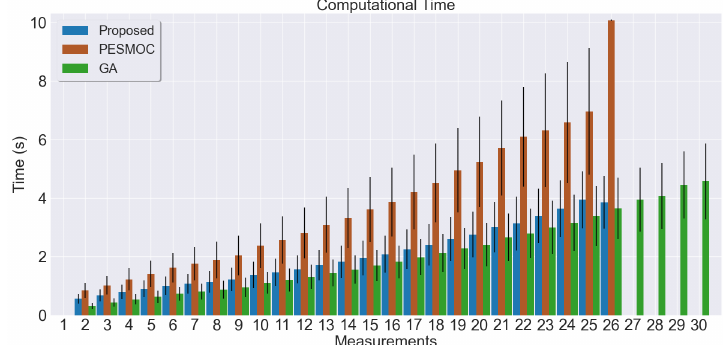
Figure 11. Number of seconds for obtaining new performed measurements for different methods. The variance in each column is large due to the fact that there are different number of surrogate models that needs to be fitted on each set of simulations (Table